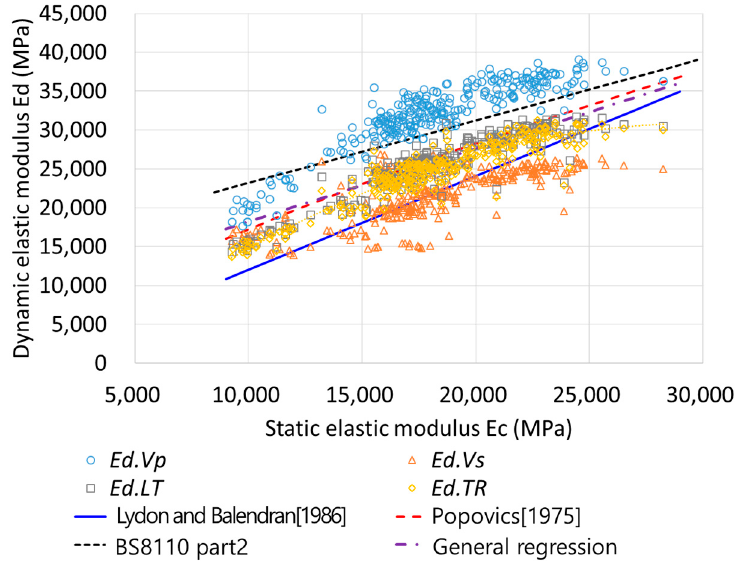
Figure 8. Relationship between Ec and Ed .